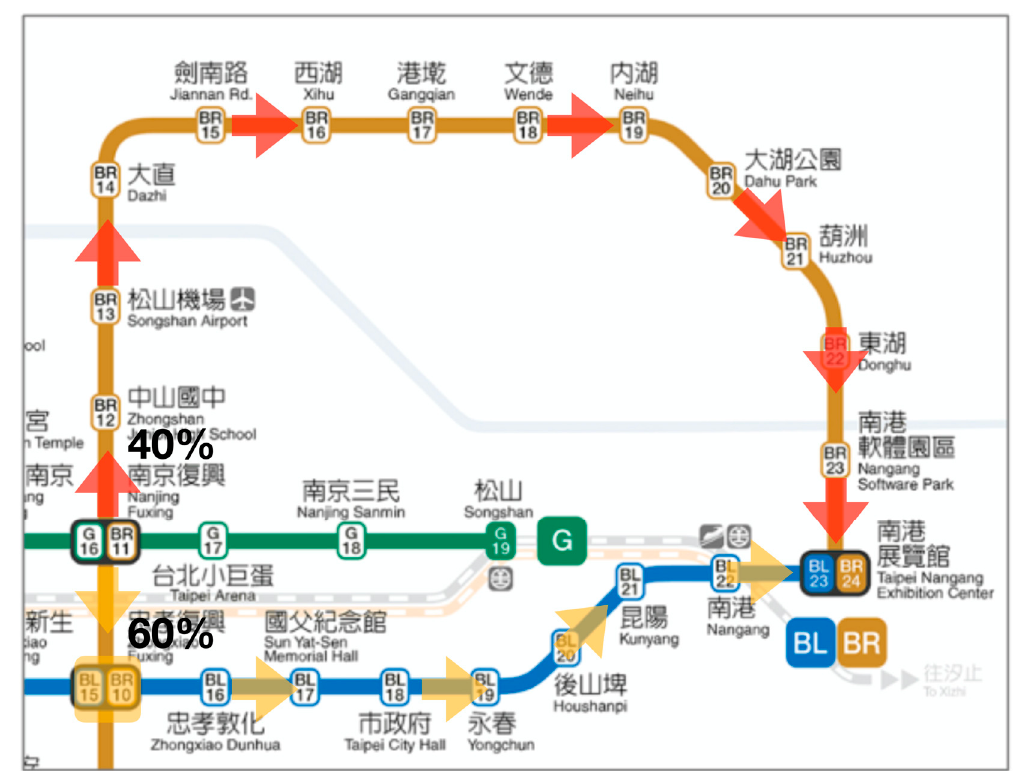
Figure 6. Overall, 60% of the participants opted to detour downward, which required an additional transfer, whereas 40% of the participants chose to detour upward and had to pass four additional stations.